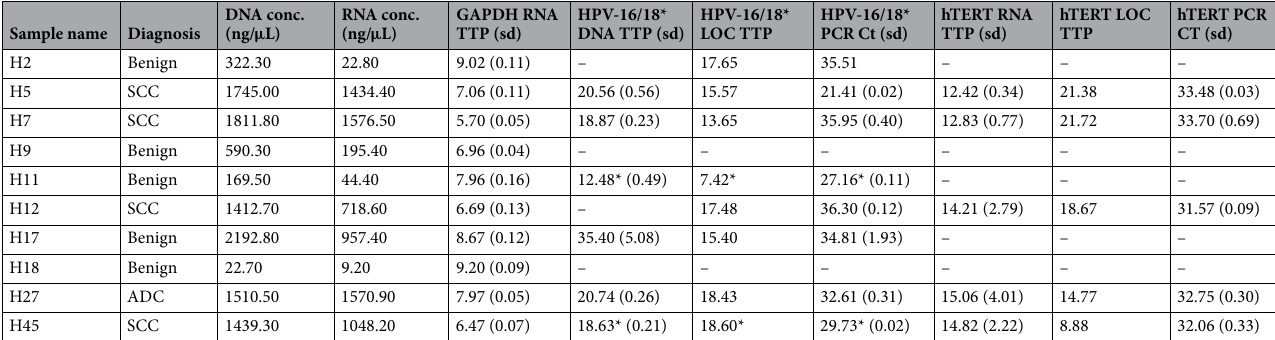
Table 1. Summary table of Nanodrop DNA and mRNA concentration, TTP and standard deviation (sd) or cycle threshold (Ct) for pH-LAMP or PCR test on LC96 system and LoC platform. *HPV-18 DNA was